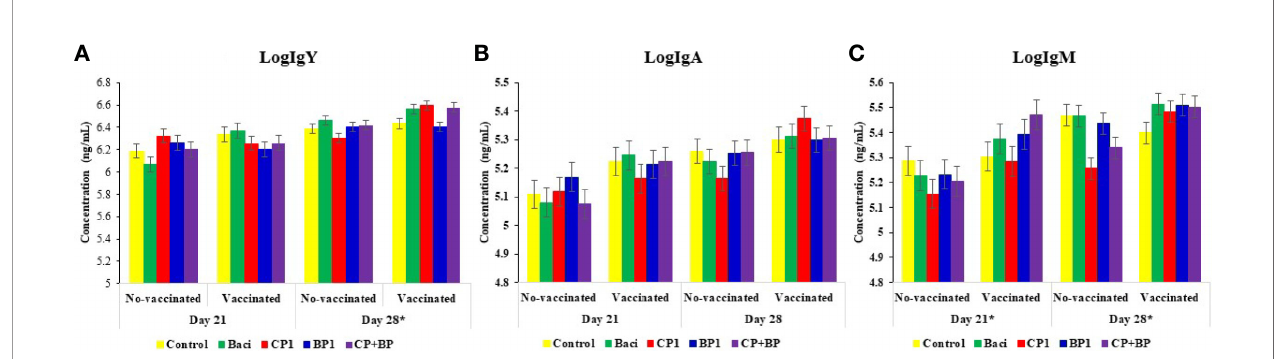
FIGURE 3 | Concentrations (ng/mL) of immunoglobulins (A) IgY, (B) IgA, and (C) IgM in blood sera of broilers at both days 21 and 28 of ages. Birds were treated with basal diet, bacitracin, different berry pomaces administrated via feed. Data represent least-square means ± SEM of 6 replicates / treatment (n = 6 pens of at least 45 chickens/pen) arranged in a complete randomized design. Asterisks indicate statistically signi fi cant differences in vaccination. *indicate statistically signi fi cant differences for both vaccination and interaction between vaccination and treatments (vac X treat) at the level of P < 0.05.